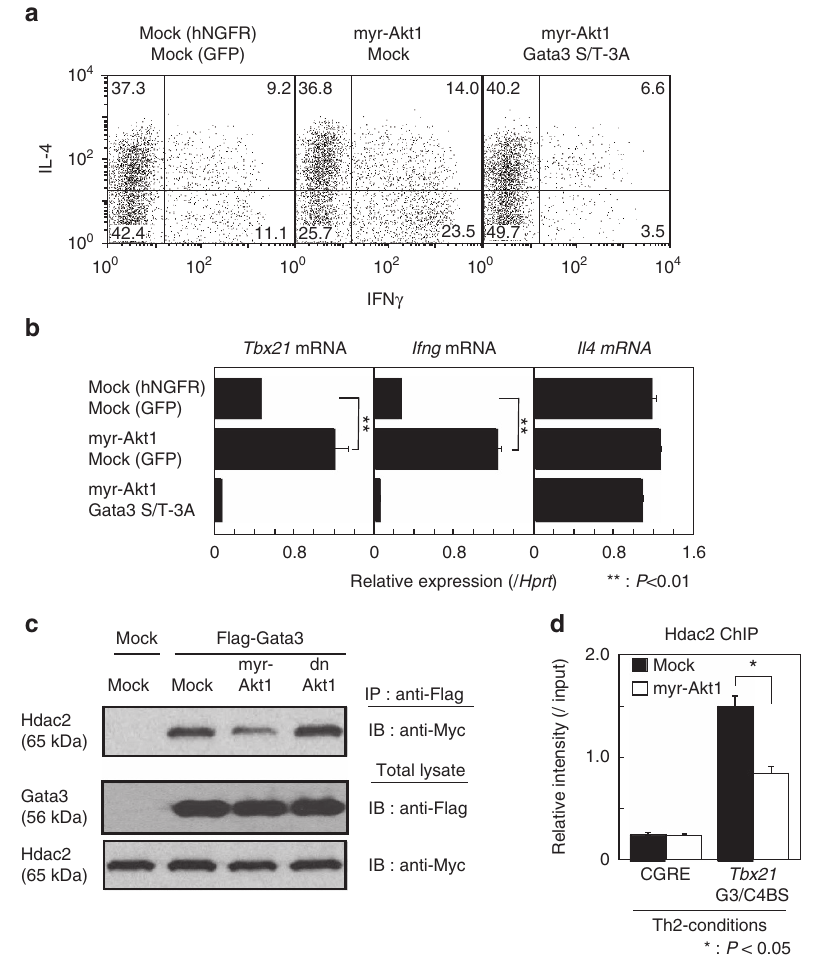
Figure 5 | Activation of Akt1 induces the derepression of the Tbx21 and Ifng expression in Th2 cells. ( a , b ) CD4 T cells were stimulated under Th2 conditions and then infected with retrovirus vectors carrying myr-Akt1 and Gata3 S/T-3A mutant cDNAs. Four days later, the cells were subjected to IL-4 and IFN g staining followed by a FACS analysis. Representative IFN g /IL-4 profiles are shown with the percentages of cells in each quadrant ( a ). The levels of mRNA of Tbx21 , Ifng and Il4 were measured by RT–qPCR ( b ). ( c ) Total lysates from Flag-tagged Gata3 and myr-Akt1 or dn Akt1-expressing 293Tcells were mixed with Myc-tagged Hdac2-expressing 293Tcell lysates. Then, the amounts of Myc-tagged Hdac2 associated with Flag-tagged Gata3 were assessed. ( d ) Binding of Hdac2 to the CGRE and the Tbx21 G3/C4BS regions was determined by ChIP assays followed by qPCR analyses in myr-Akt1 introduced